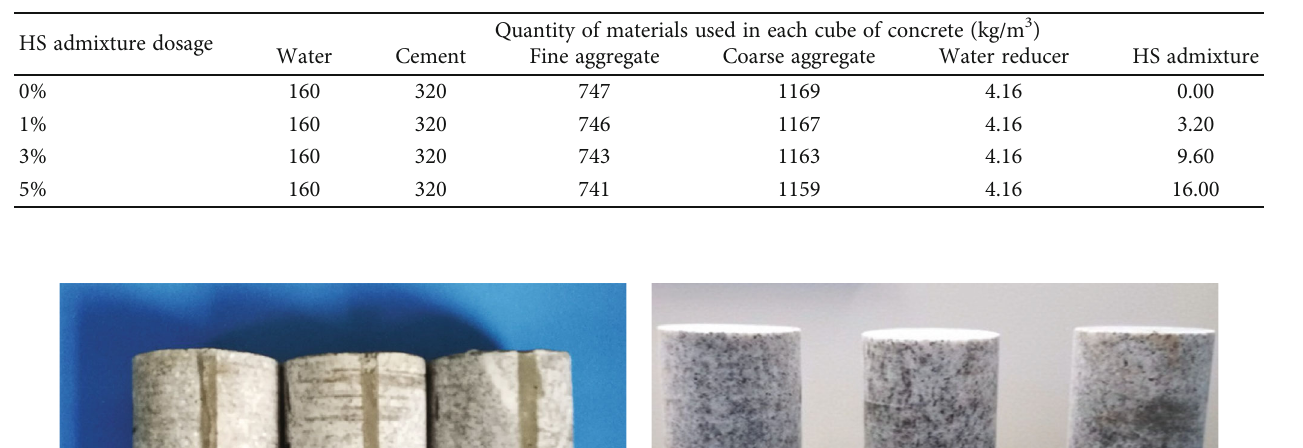
Table 1: Mix ratios of concrete with di ff erent HS admixture dosages.